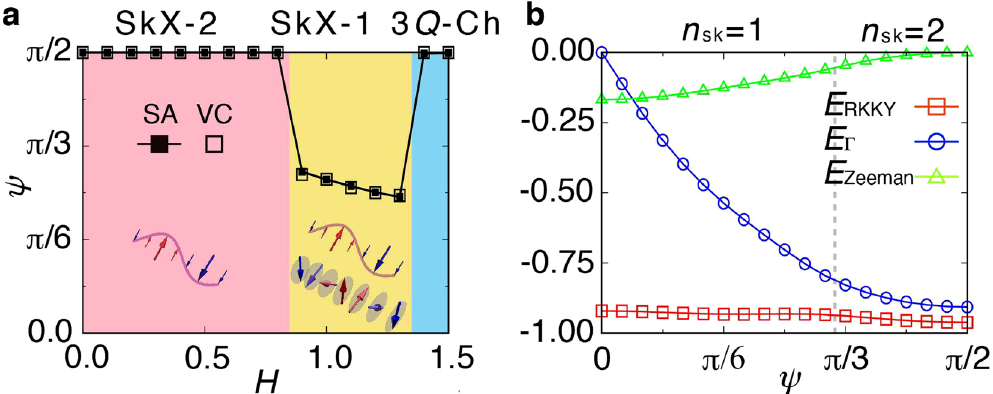
0.2 . Schematic = 0 , 1 / √ 2 , m z = =